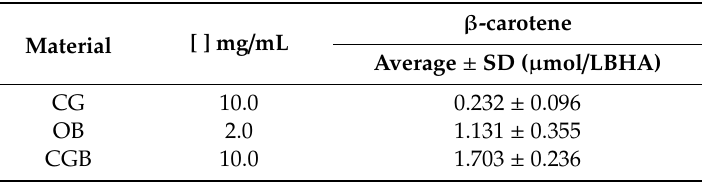
Table 4. Antioxidant activity assessed by the β -carotene method for pure chitosan gel (CG) buriti oil (OB) and gel with buriti oil (CGB)